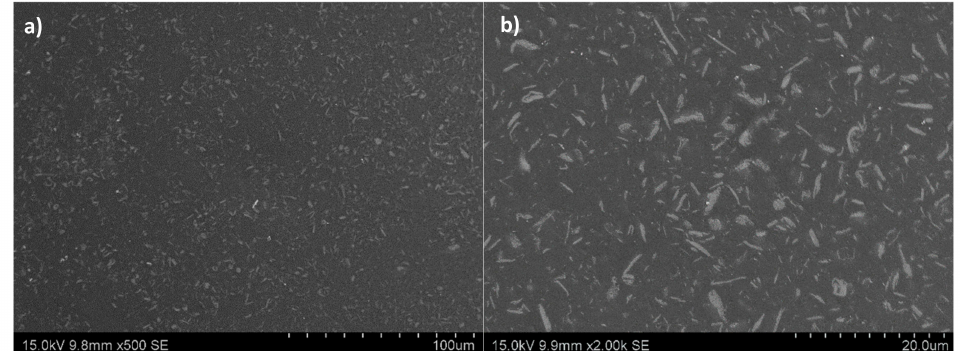
Figure 2. SEM images of the dispersion achieved in the epoxy / graphene nanoplatelets (GNPs) nanocomposites: ( a ) With 5 wt.% of nonfunctionalised GNPs and ( b ) 8 wt.% of functionalised